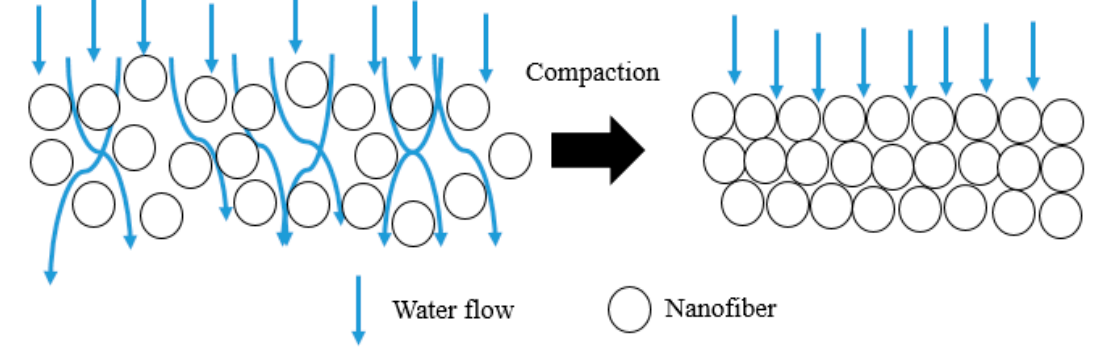
Figure 10. Membrane compaction process. Table 2. Rejection analysis for untreated nylon 6,6 NFM and nylon 6,6 // ZIF-8